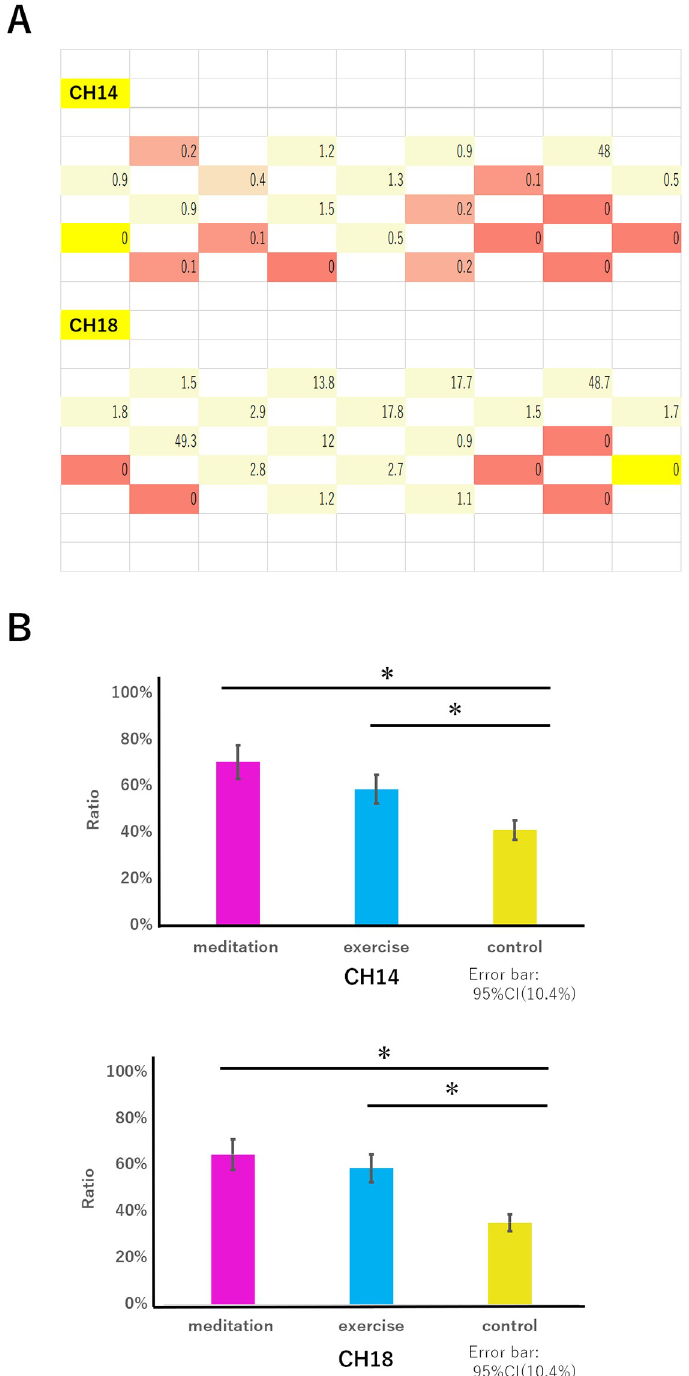
Fig 7. Signal source analysis for CH14 and CH18. A . Representative data of spread of signals originating in CH14 and CH18 are shown. Numbers indicate the time at the maximum peak value of the correlation coefficients after the peak emergence of CH14 or CH18. B . Ratios of CH14 or CH18 recognized as the signal source are shown for the 17 participants. Error bars indicate 95% CI ( e . g ., 10.4% for both CH14 and CH18), and if the error bars did not overlap, we determined that there was a significant difference between the tasks. � indicates a significant